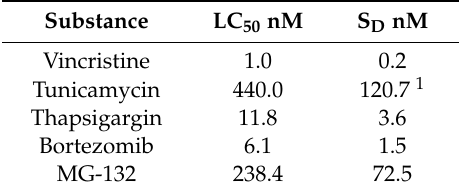
Table 1. Median lethal concentrations of vincristine and endoplasmic reticulum (ER) stressors for S